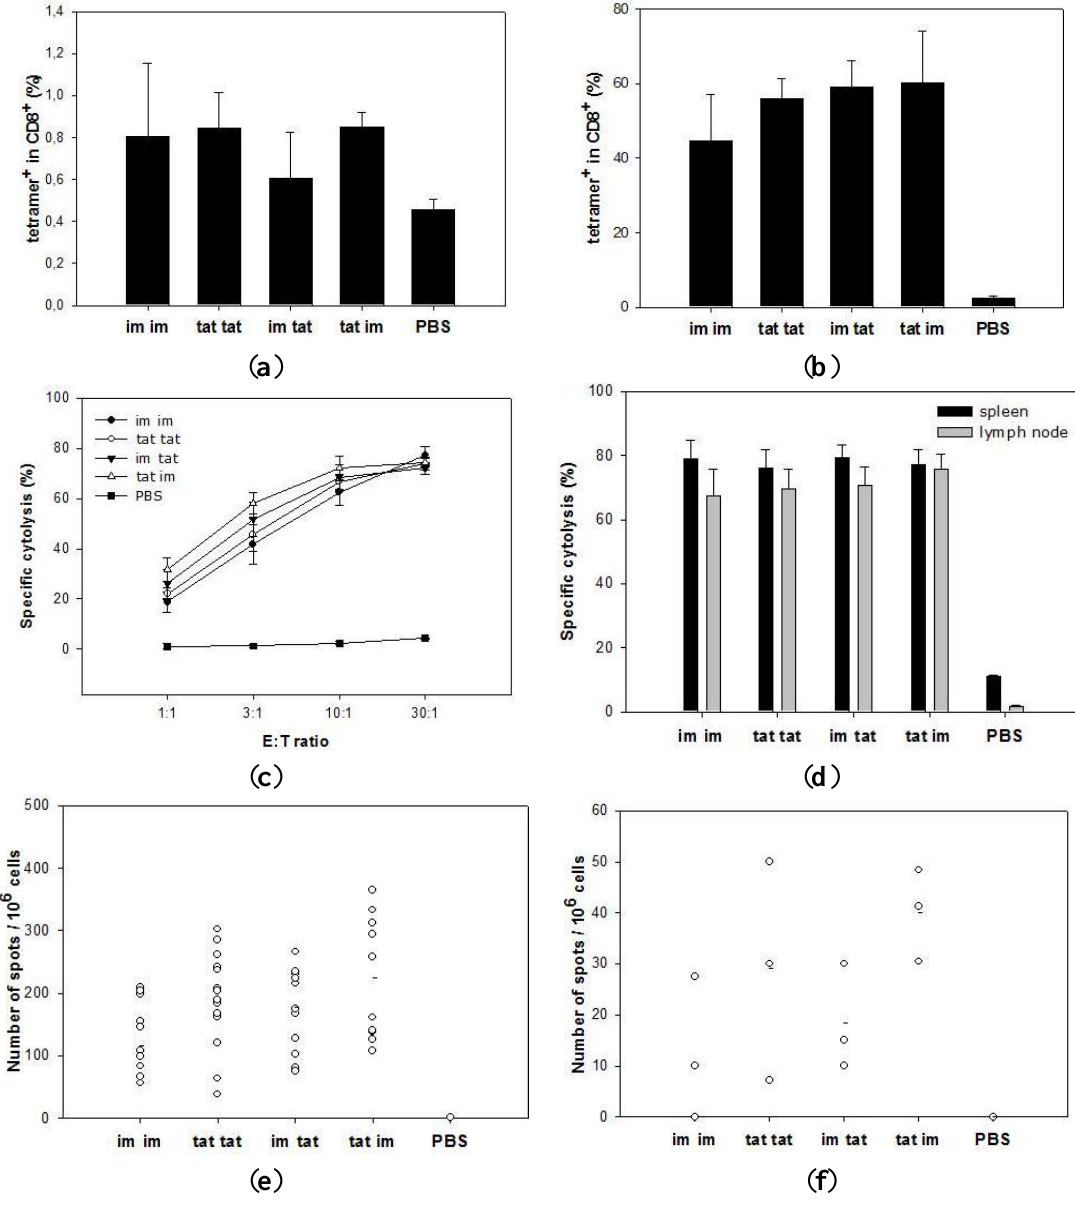
Figure 2. SFVeE6,7 tattoo injections induce strong T cell responses. Mice were tattooed or intramuscularly immunized with 5 × 10 6 i.u. of SFVeE6,7 and boosted 14 days later using the same or alternative delivery route. Ten days after the booster immunization animals were sacrificed. Freshly isolated ( a ) and 7-day in vitro restimulated spleen cells ( b ) were stained with MHC class I tetramers and anti-CD8 antibodies and analyzed by flow cytometry. The percentages of tetramer-positive cells within the CD8 T cells are shown. Activity of restimulated spleen and inguinal lymph node cells were analyzed in regular ( c ); only spleen cells) and micro CTL assay ( d ; both spleen and lymph node cells). The frequencies of IFNγ-producing cells, both in the spleens and inguinal lymph nodes, were determined using Elispot assay. Results are expressed as number of IFNγ-producing cells per 10 6 splenocytes ( e ) or per 10 6 lymph node cells ( f ). Each dot represents an individual mouse; a – d —data from a representative experiment out of four (three mice/group); e —pooled data from four experiments; f —data from one experiment. E:T ratio—effector:target ratio. * p < 0.05 as compared with the im